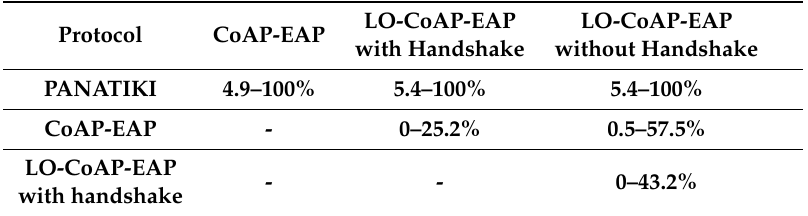
Figure 7. Success ratio in Cooja for LO-CoAP-EAP, CoAP-EAP and PANATIKI. ( a ) Success ratio with 0.0 loss ratio; ( b ) success ratio with 0.1 loss ratio; ( c ) success ratio with 0.2 loss ratio. Table 5. Success ratio